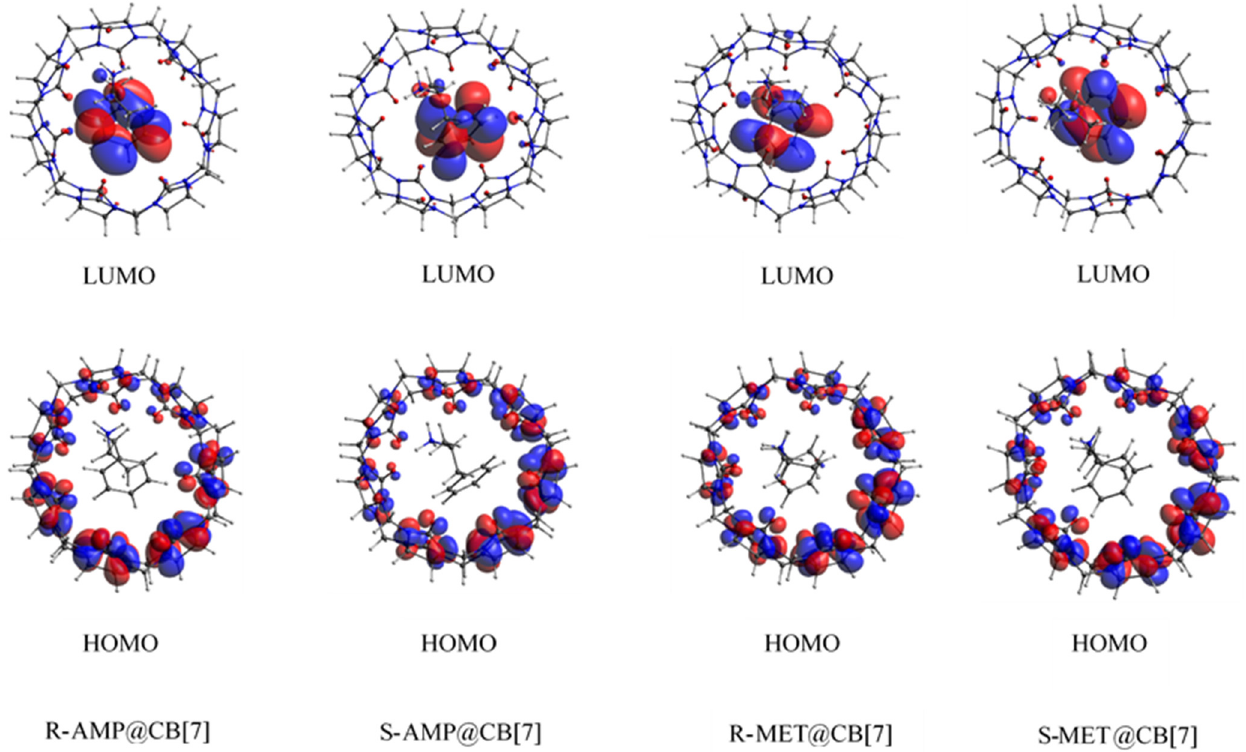
Figure 4. HOMO and LUMO plots of R-AMP@CB[7], S-AMP@CB[7], R-MET@CB[7] and S-AMP@CB[7].